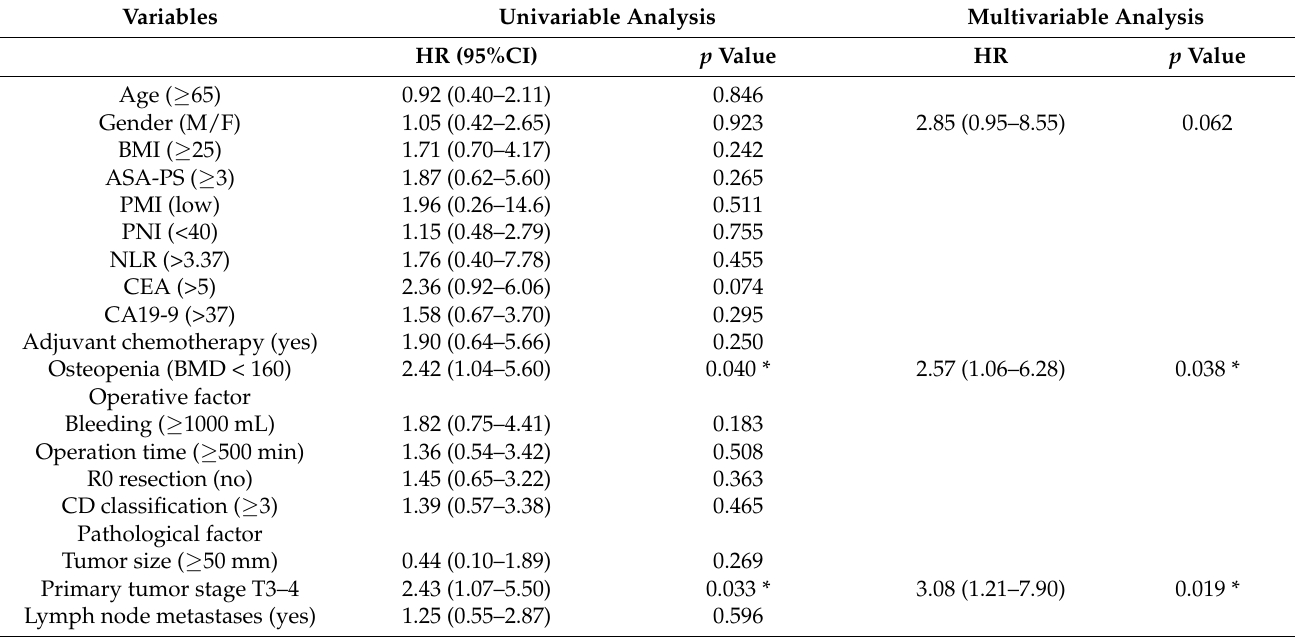
Table 2. Univariate and multivariable analysis of factors associated with overall survival in patients with perihilar cholangiocarcinoma.